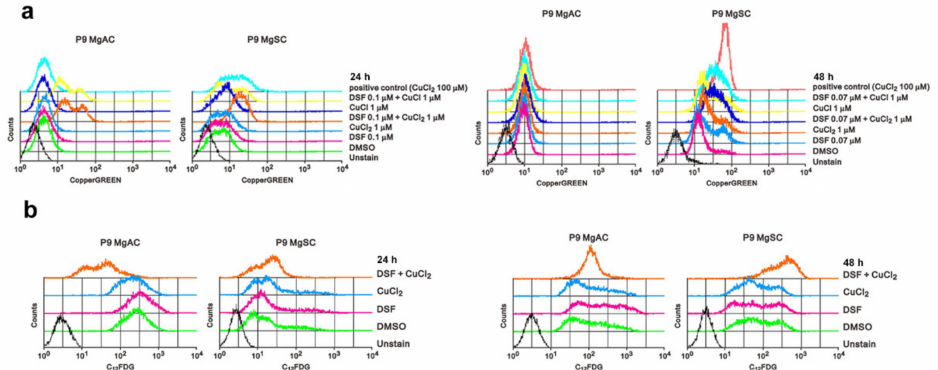
Figure 5. DSF/Cu induces intracellular copper accumulation and cell senescence in meningioma cells. ( a ) Cells were incubated for 24 h and 48 h with the indicated concentrations of DSF and Cu alone and in combination. Intracellular Cu + concentrations were measured using CopperGREEN dye and analyzed with flow cytometry. Cells without CopperGREEN served as blanks. ( b ) Cells were incubated for 24 h or 48 h with 0.1 µ M DSF with or without 1 µ M CuCl 2 , after which they were stained with C 12 FDG and assayed using a flow cytometer. Cells without C 12 FDG served as